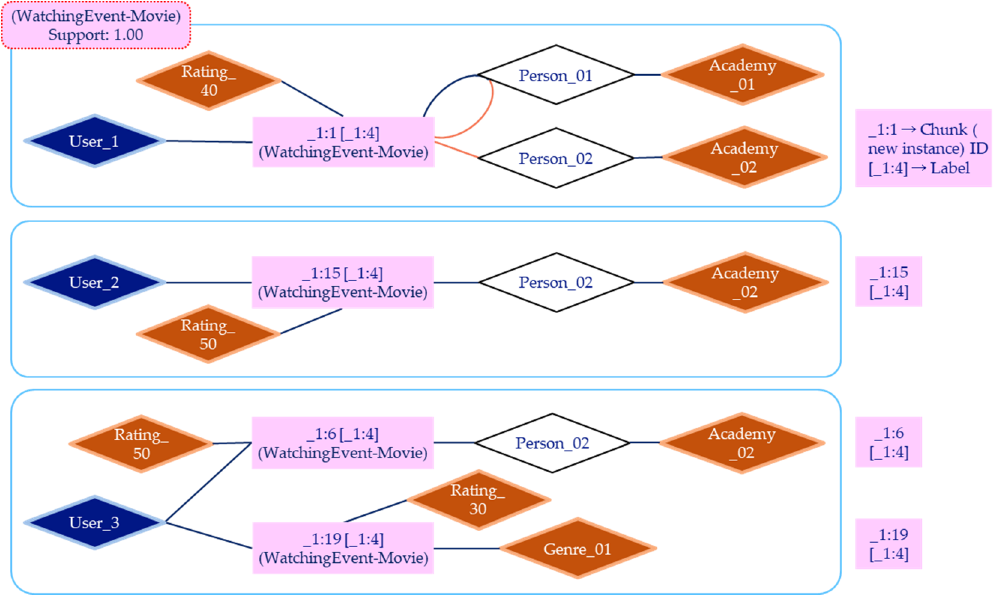
Figure 12. Unit subgraphs after 1st chunking.